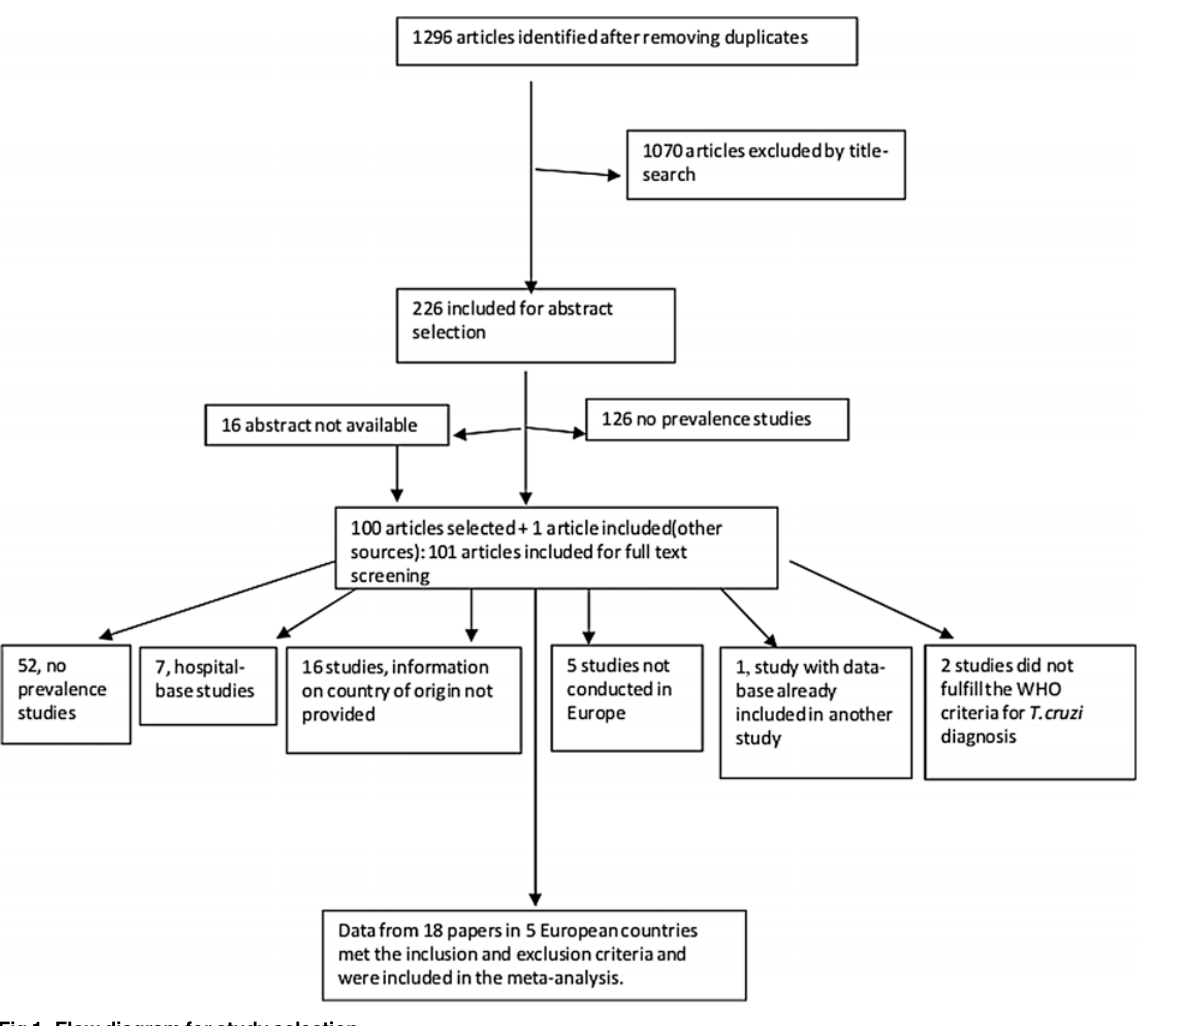
Fig 1. Flow diagram for study